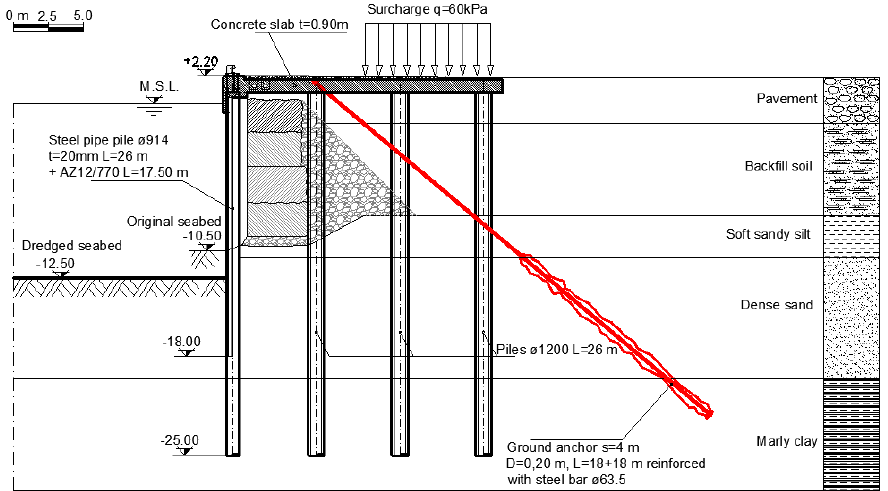
Figure 1. Cross-section of the quay with the upgrading work. Note the location of the ground anchor (modified from [13]).